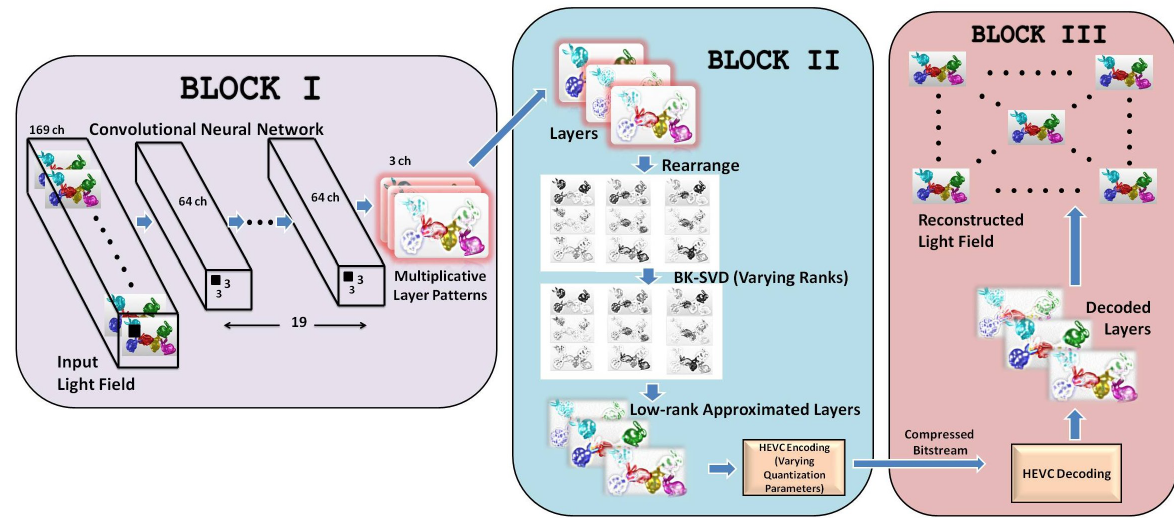
Figure 2. The complete workflow of the proposed scheme comprising of three prime components: conversion of light field views into multiplicative layers, low-rank approximation of layers and HEVC encoding, and the decoding of the approximated layers followed by the reconstruction of the light